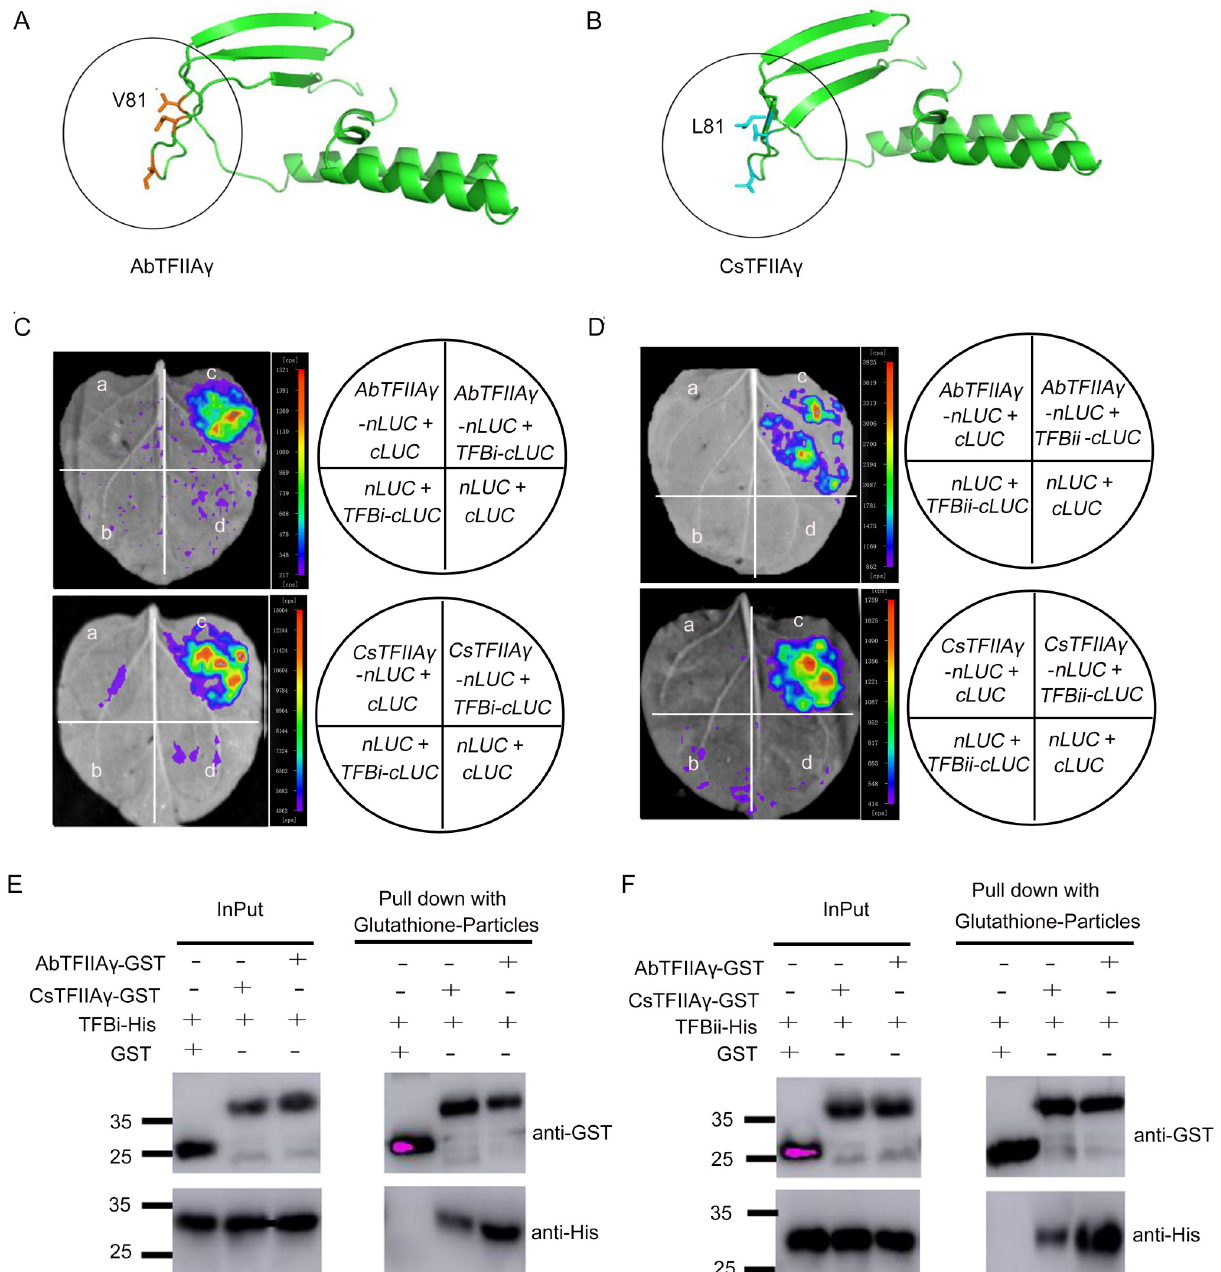
Fig 4. Interactions of AbTFIIA γ or CsTFIIA γ with TALE TFBs. (A) Homology modeling of AbTFIIA γ protein. (B) Homology modeling of CsTFIIA γ protein. The structures of TFIIA γ proteins were homology modeled using SWISS-MODEL online service with default parameters (Fig 4A and 4B). (C) Interactions between AbTFIIA γ -nLuc or CsTFIIA γ -nLuc and TFBi-cLuc. (D) Interactions between AbTFIIA γ -nLuc or CsTFIIA γ -nLuc and TFBii-cLuc. Note: a, b, and d indicate the negative controls of tobacco leaves; c denotes the interactions between TFBi-cLuc or TFBii-cLuc and AbTFIIA γ -nLuc or CsTFIIA γ -nLuc in tobacco leaves in luciferase complementation assay (Fig 4C and 4D). (E) The interaction of AbTFIIA γ or CsTFIIA γ with TFBi in pull- down assays. (F) The interaction of AbTFIIA γ or CsTFIIA γ with TFBii in Pull-down assays. Note: GST-tagged AbTFIIA γ or GST-tagged CsTFIIA γ and His-tagged TFBi or His-tagged TFBii were incubated with immobilized glutathione S-transferase (GST) (Fig 4E and 4F). The experiments were repeated three times independently.